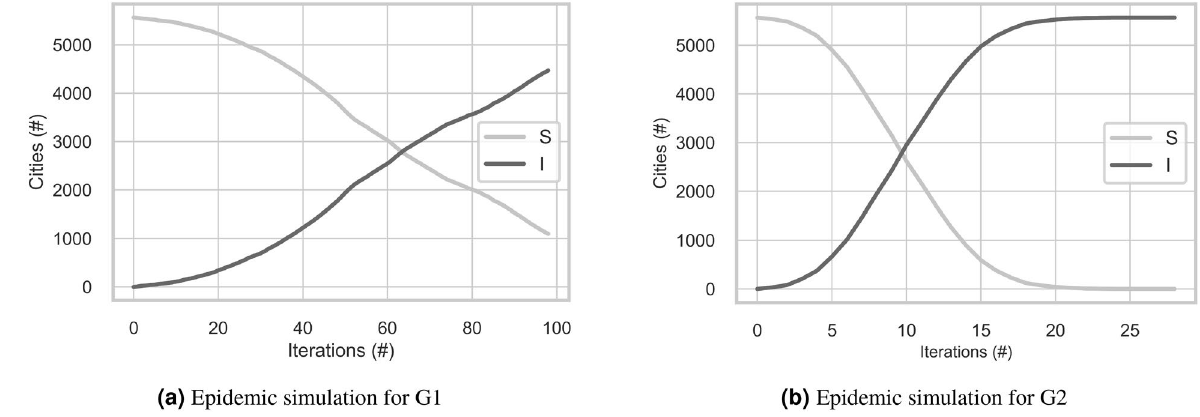
Figure 1. Epidemic simulation.